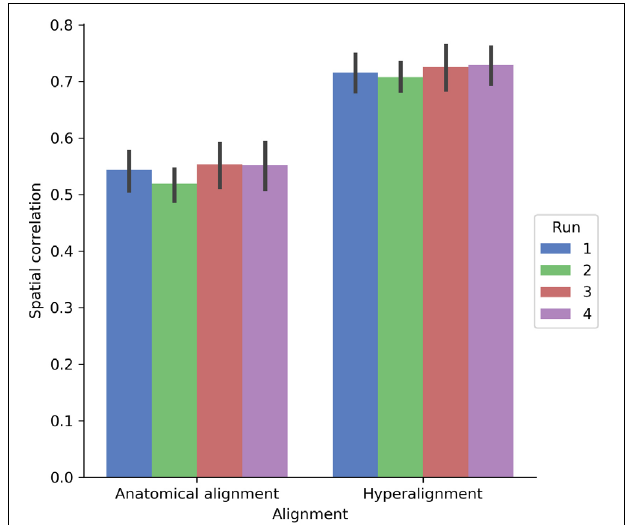
FIGURE 8 | Spatial correlation between within-subject model prediction performance maps and between-subject model prediction performance maps using either anatomical alignment or hyperalignment. The between-subject model using hyperalignment yielded a model performance map that is more similar to the within-subject model than the model performance map of the between-subject model using anatomical alignment. The height of each bar indicates mean spatial correlation across participants for each run. Error bars indicate bootstrapped 95% confidence intervals estimated by resampling participants (1,000 bootstrap